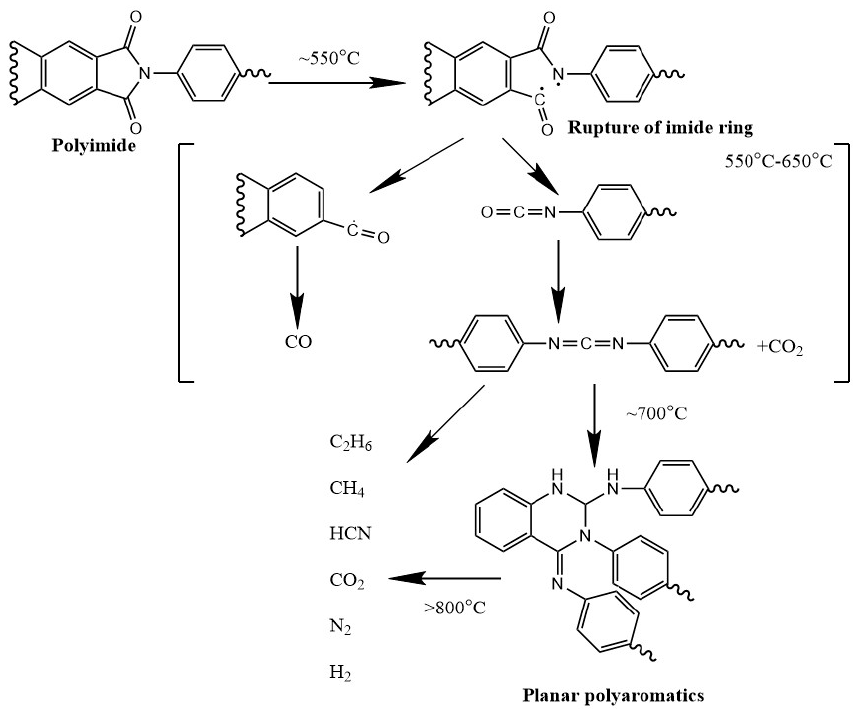
Scheme 1. Representation of the degradation mechanism of polyimide in air atmosphere [47].